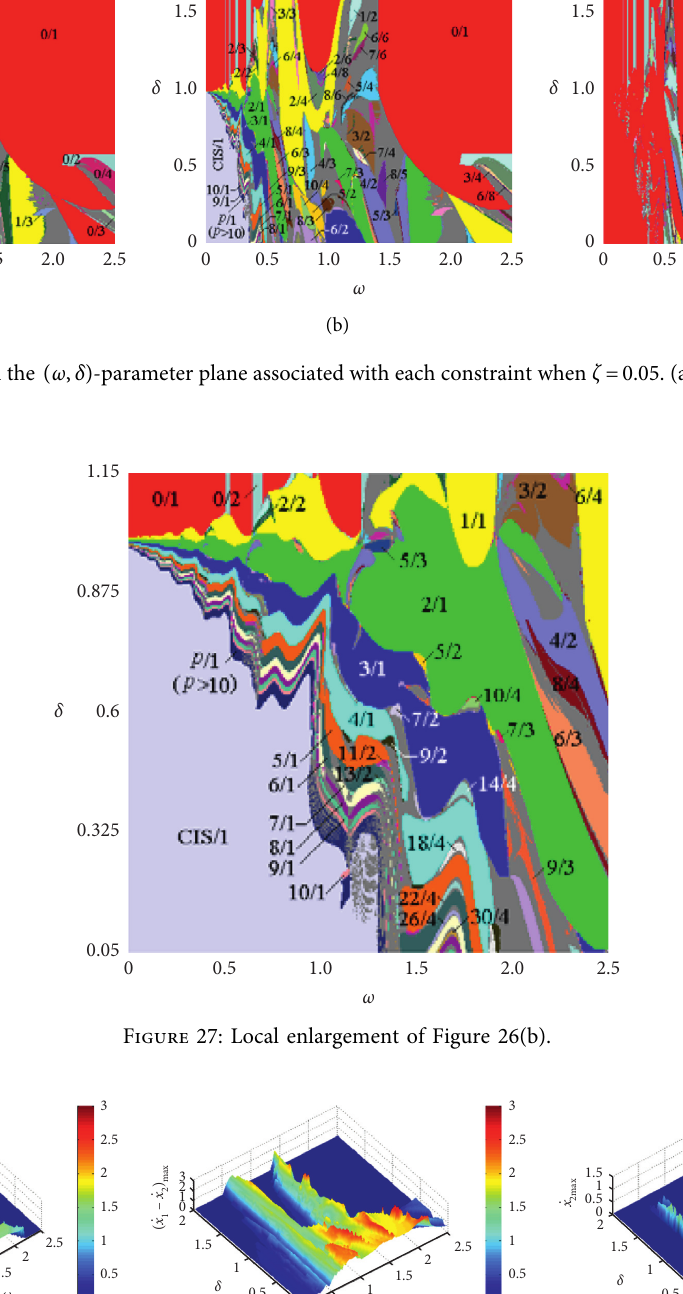
Figure 28: Three-dimensional surface diagrams of the maximum impact velocity of the system associated with each constraint when ζ � 0.05. (a) Constraint A 1 ; (b) constraint A 12 ; (c) constraint A 2